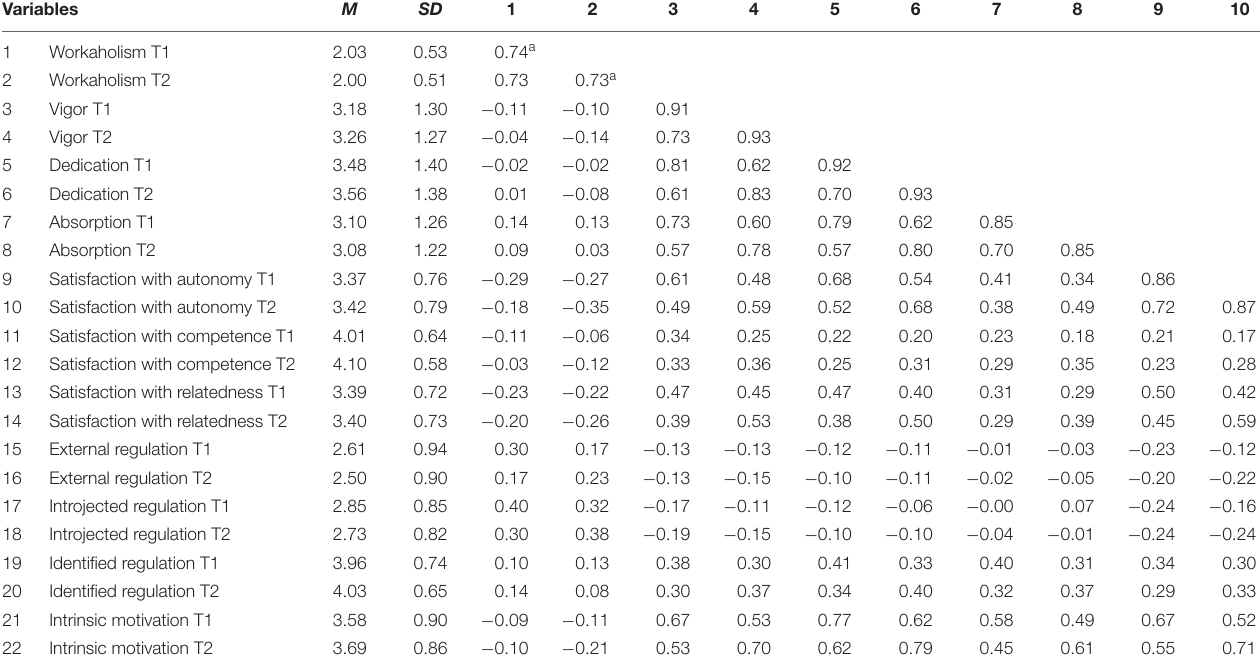
TABLE 2 | Means, standard deviations, correlations, and Cronbach’s alpha coefficients on the diagonal ( N =